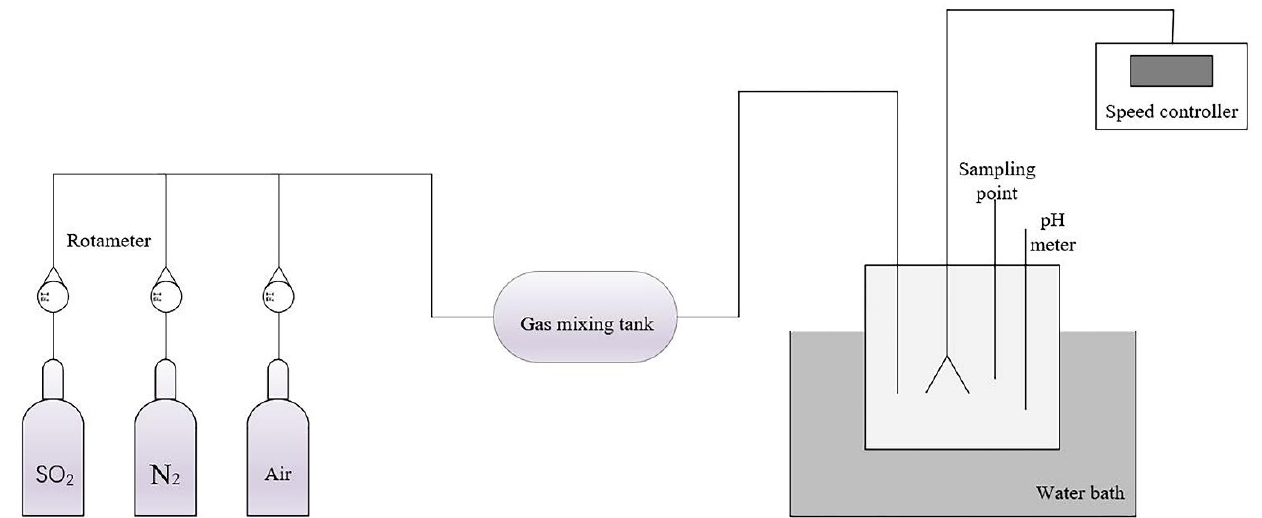
Figure 1. Scheme of calcium sulfite catalytic oxidation experiment. The concentration of SO 32 − is determined by iodometric method. First, 20 mL of iodine solution with a concentration of 0.05 mol/L was added to 10 mL slurry from the reactor. To the resulting mixture, 5 mL of hydrochloric acid (1 + 4) solution was added to provide the acidic environment required for the reaction. Then, the mixture was kept in the dark for 5 min. Second, 0.05 mol/L Na 2 S 2 O 3 solution was used to titrate the solution until the pale yellow color disappeared. The Na 2 S 2 O 3 volume consumed during each